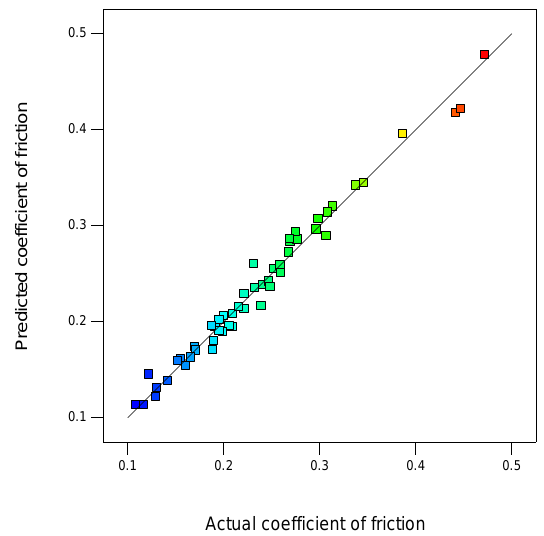
Figure 6. Actual versus predicted scattering of the data points.